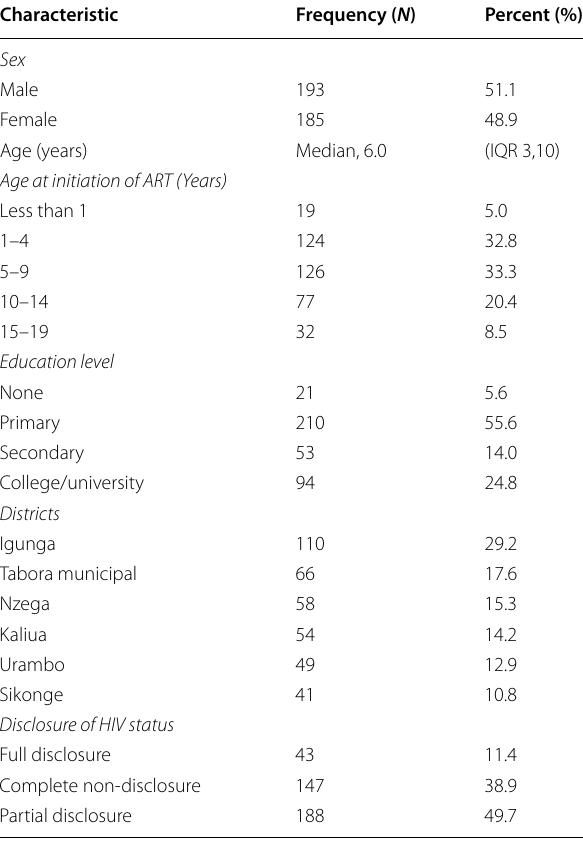
Table 1 Socio-demographic characteristics and HIV disclosure status of HIV-positive children and adolescents on ART in Tabora